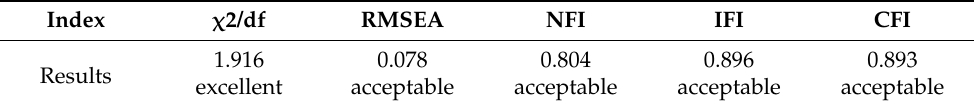
Table 7. Modified SEM fit results.